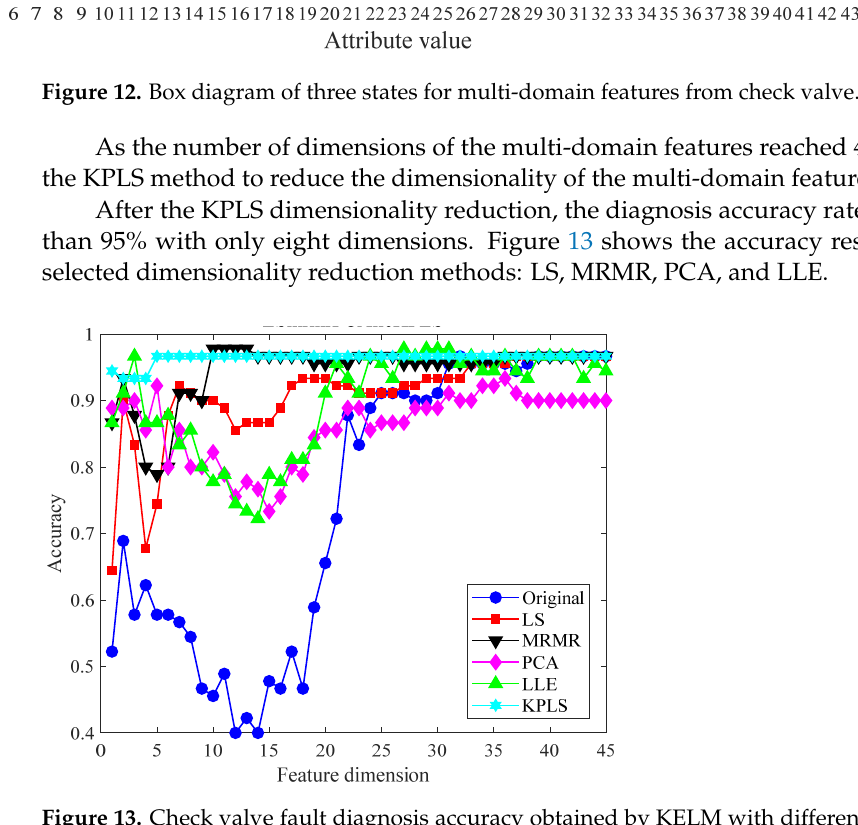
Figure 13. Check valve fault diagnosis accuracy obtained by KELM with different dimensionality reduction methods.